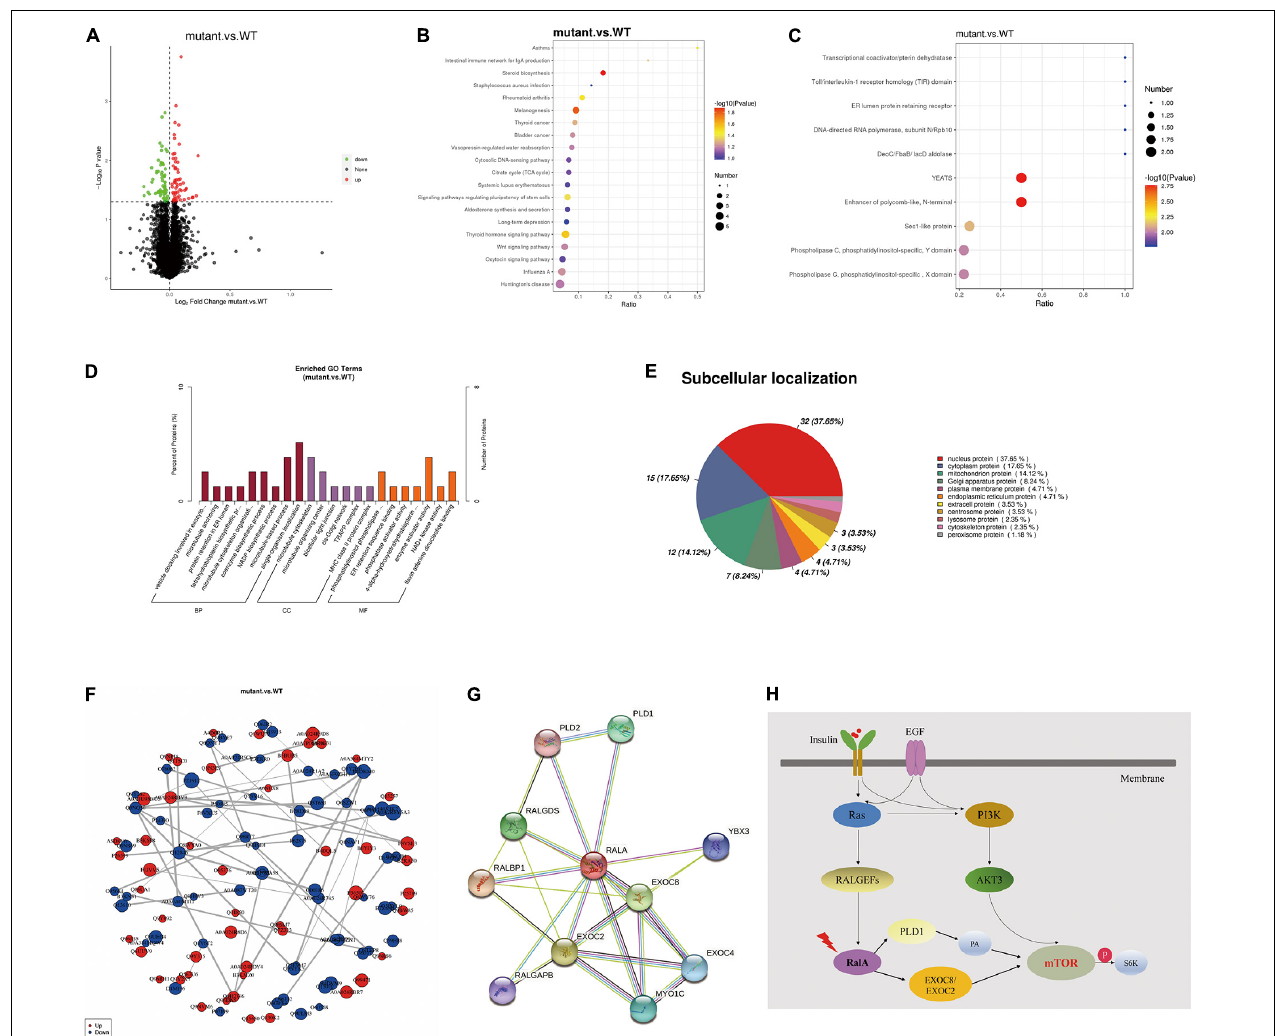
FIGURE 4 | Tandem mass tag (TMT) quantitative proteomics assay. (A) Differential proteins volcano map. The horizontal axis represents the multiple of difference (Log2 value) of differential proteins, the vertical axis represents P -value (–log10 value), the black represents the protein with no significant difference, the red represents the upregulated protein, and the green represents the downregulated protein. (B) Kyoto Encyclopedia of Genes and Genomes (KEGG) enrichment bubble chart. The abscissa in the figure is the ratio of the number of differential proteins in the corresponding pathway to the total number of proteins identified in the pathway. The size of the point represents the number of differential proteins in the corresponding pathway. The larger the point, the more differential proteins in the pathway. (C) Interproscan software enrichment scatterplot. The abscissa is the ratio of the number of differential proteins in the corresponding domain to the total number of proteins identified in the domain. The size of the point represents the number of differential proteins in the corresponding domain. The larger the point, the more differential proteins in the domain. (D) Gene ontology enrichment analysis histogram. BP, GO_Class, biological process; CC, GO_Class, cellular component; MF, GO_Class, molecular function. x , the number of differential proteins associated with the gene ontology (GO); n , number of differential proteins annotated by GO. The diagram shows the enrichment of the three categories as a result, each show at most 20 ( P -value ≤ 0.05), and the percentage of the ordinate represents the x / n in the table. (E) Subcellular localization analysis of differential proteins. (F) Differential protein-protein interaction analysis. Each node in the interaction network represents a protein, and the node size represents the number of proteins interacting with it. The larger the node, the more the proteins interacting with it. The color of the node indicates the expression level of this protein in the comparison pair. The red color represents the upregulated proteins, and the blue color represents the significantly downregulated proteins. (G) Top 10 proteins that interact with RalA, identified using the String DB protein interaction database (http://string-db.org/). (H) RALA somatic variant might activate mTOR pathway through downstream effectors PLD1 or